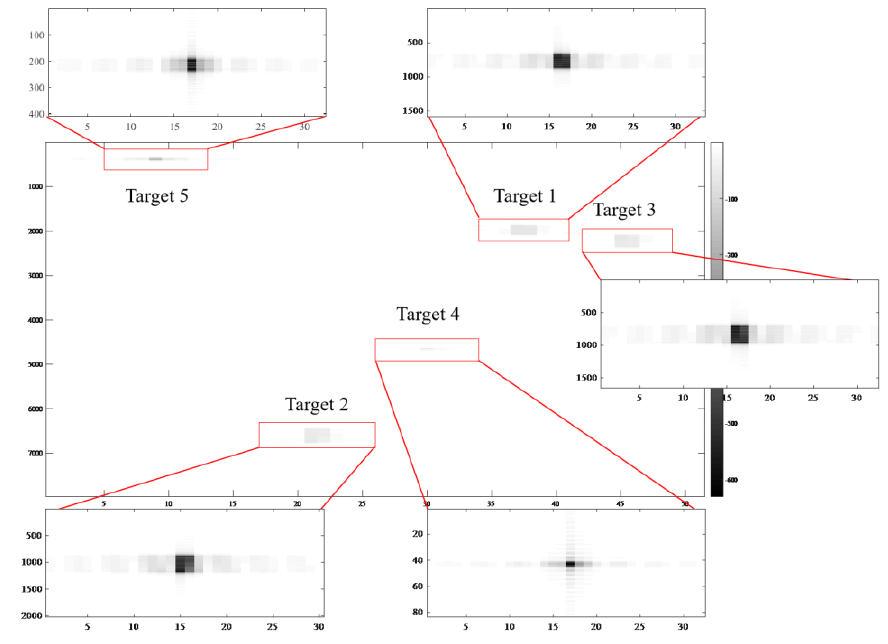
Figure 8. SAR image of the five targets.